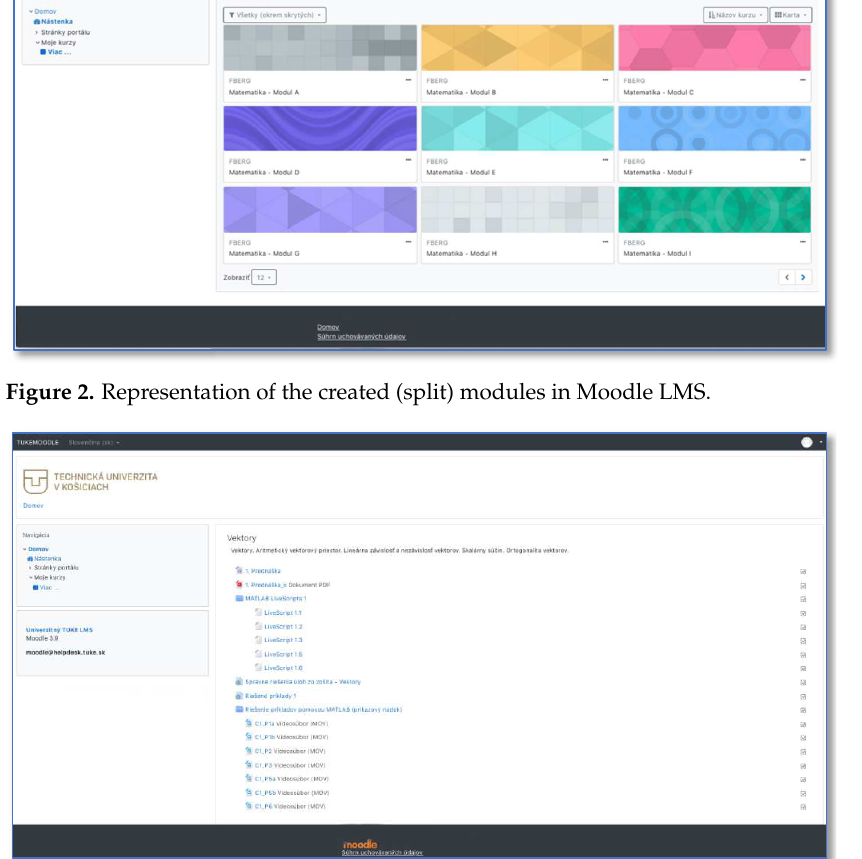
Figure 3. An example of one of sets of textual and multimedia study materials from Module A.